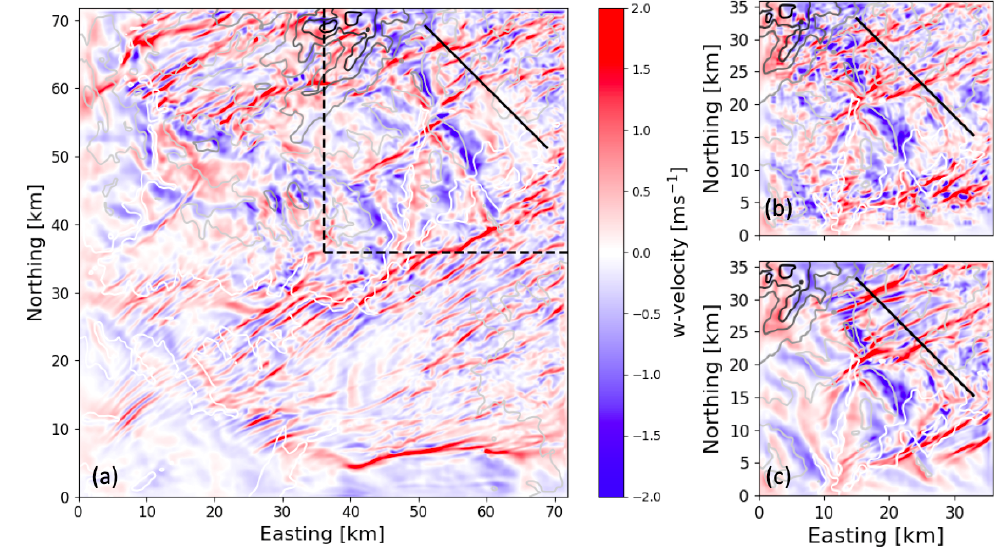
Figure 5. Vertical velocity (m/s) at 260 m above ground level for a WRF LES grid at 150 m resolution at 1900 LT. Line contours of topography (white-gray) are shown: ( a ) a large reference domain without CPM is compared to ( b ) a small domain with CPM and ( c ) a small domain without CPM. The dashed lines in ( a ) show the spatial extent of the small domains in ( b , c ), which are the same as the domain in Figure 2c. The diagonal lines are used for the w-spectra comparison in Figure